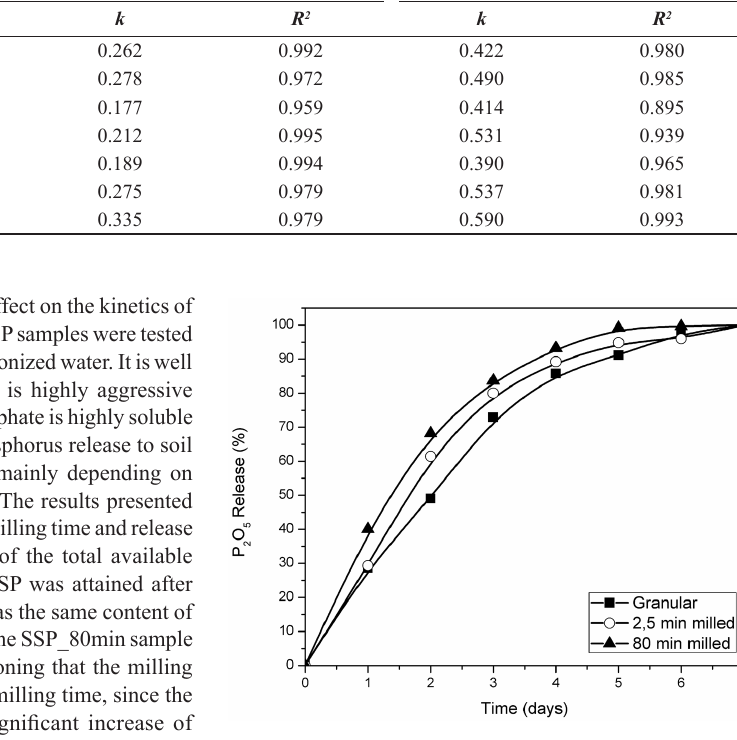
Table 4. Kinetic parameters of the phosphate release experiments Sample